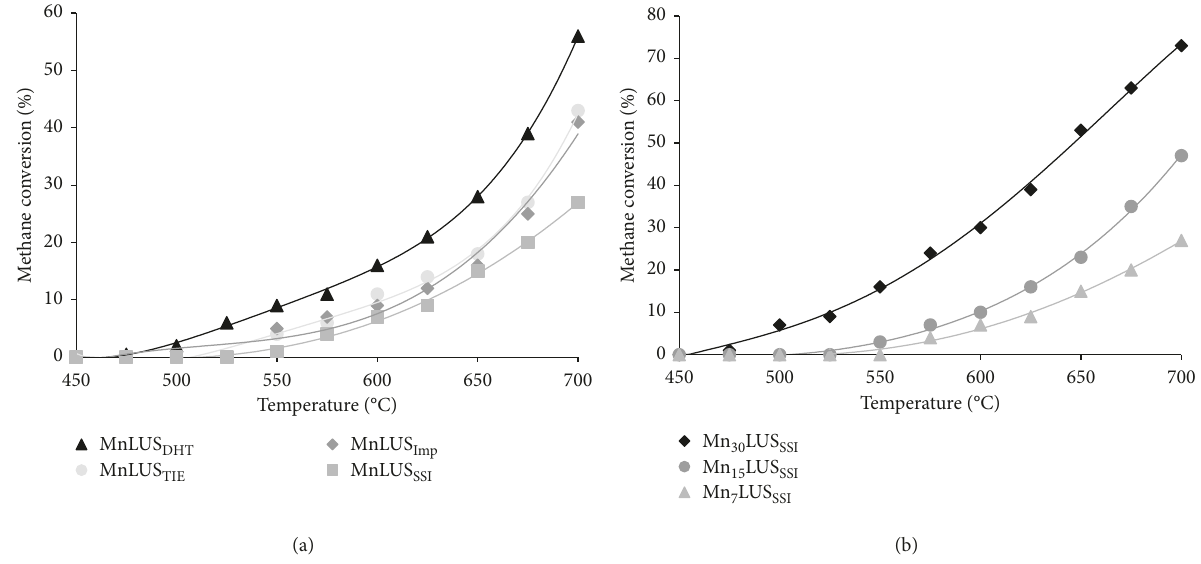
Figure 7: Methane conversion as a function of reaction temperature of (a) MnLUS (7 wt.%): MnLUS MnLUS SSI and (b) reaction temperature of Mn 7 LUS SSI , Mn 15 LUS SSI , and Mn 30 LUS SSI . Mass of the catalyst:100mg; gas mixture: CH 4 /O 2 /He � 1/4/95 (% vol); total flow rate: 100cm 3 min − 1